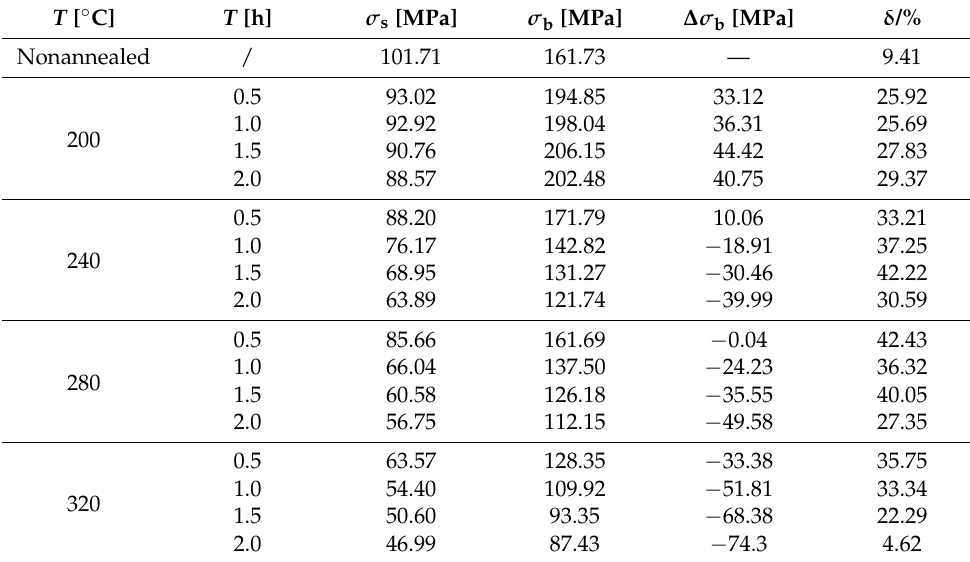
Table 4. Yield strength ( σ s ), tensile strength ( σ b ) and uniform elongation ( δ ) of Al/Zn laminate under different annealing conditions, ∆ σ b represents the difference in tensile strength between annealed and non-annealed.